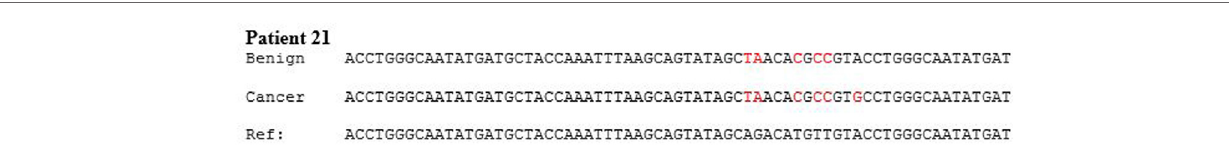
FigUre 2 | hPV type 18 Dna sequences in benign breast and subsequent breast cancer . There are identical sequence variations of a PCR product Gp5 + to Gp6 + in both the benign and later breast cancer in patient 21. (The sequence has been abbreviated to include the differences). This indicates it is the same virus and differs from the reference sequences based on HeLa cervical cell culture.